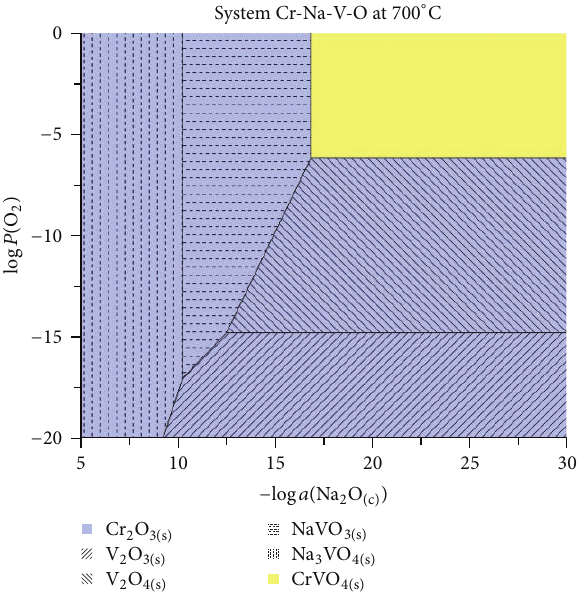
Figure 8: Thermodynamic stability diagrams for Cr-Na-V-O at 700 ∘ C.